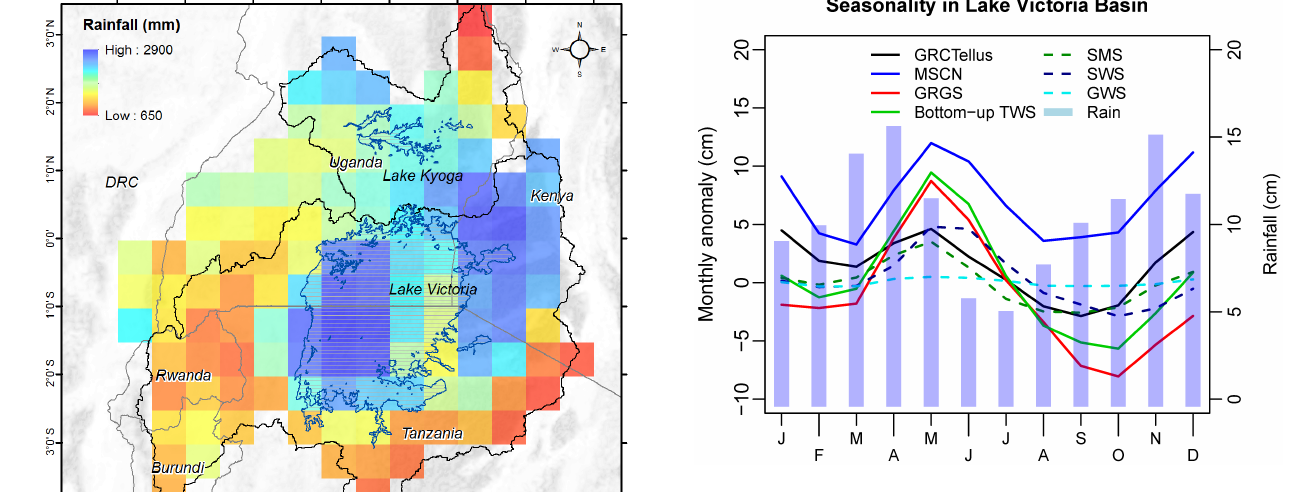
Figure 4. Seasonal pattern (monthly mean from January 2003 to December 2012) of TRMM-derived monthly rainfall, various GRACE-derived (cid:49) TWS signals (GRCTellus: ensemble mean of CSR, JPL, and GFZ; GRGS and JPL-Mascons (MSCN) products), the bottom-up TWS, GLDAS LSM ensemble mean (cid:49) SMS, in situ (cid:49) SWS, and a borehole-derived estimate of (cid:49) GWS over the Lake Victoria